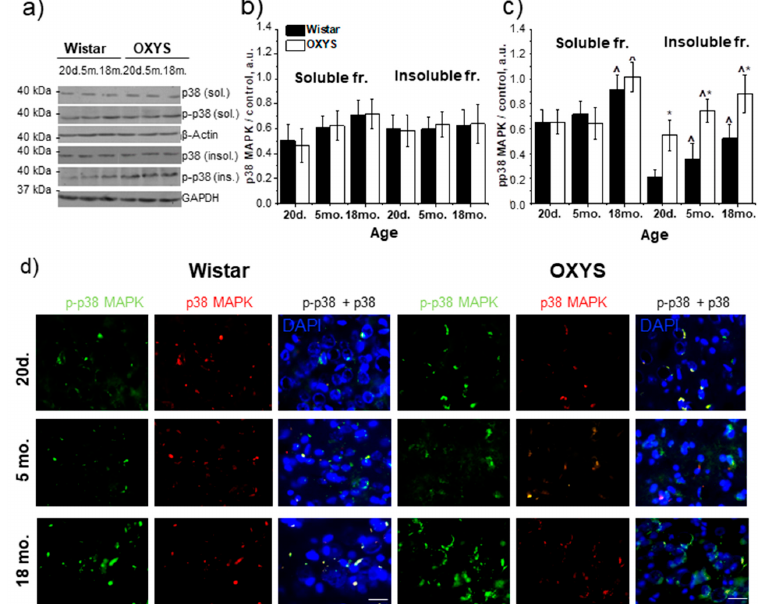
Figure 2. The protein content of p38 MAPK and p-p38 MAPK in the hippocampus of 20-day-old and 5- and 18-month-old Wistar and OXYS rats. ( a ) Representative western blots of total and phosphorylated p38 MAPK in the detergent-soluble and detergent-insoluble fractions from the hippocampus of Wistar and OXYS rats. Graphical presentation illustrates the relative protein content of p38 MAPK ( b ) and p-p38 MAPK ( c ) in Wistar and OXYS rats’ hippocampi at di ff erent ages after normalization of the detergent-soluble fraction data to β -actin and detergent-insoluble fraction data to GAPDH. Data are presented as mean ± SEM of five independent experiments. Immunostaining for p38 MAPK and p-p38 MAPK ( d ) in the hippocampus of 20-day-old and 5- and 18-month-old Wistar and OXYS rats. The nuclei were stained with DAPI (blue). Scale bars, 25 µ m. * Statistically significant di ff erences between the strains of the same age; ˆ significant di ff erences from the previous age within a strain ( p <